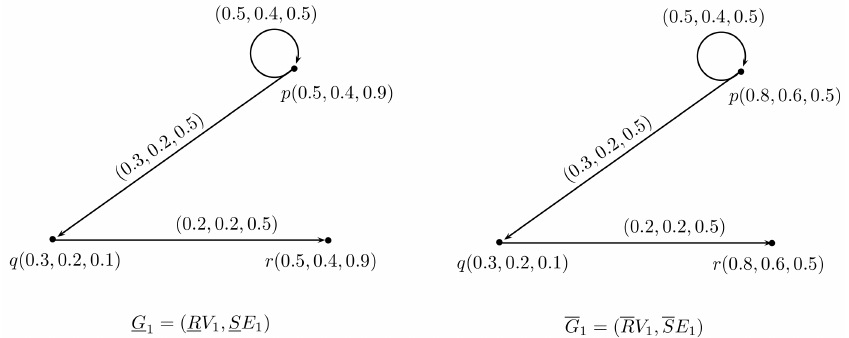
Figure 8. Rough neutrosophic digraph G 1 = ( G 1 , G 1 ) .